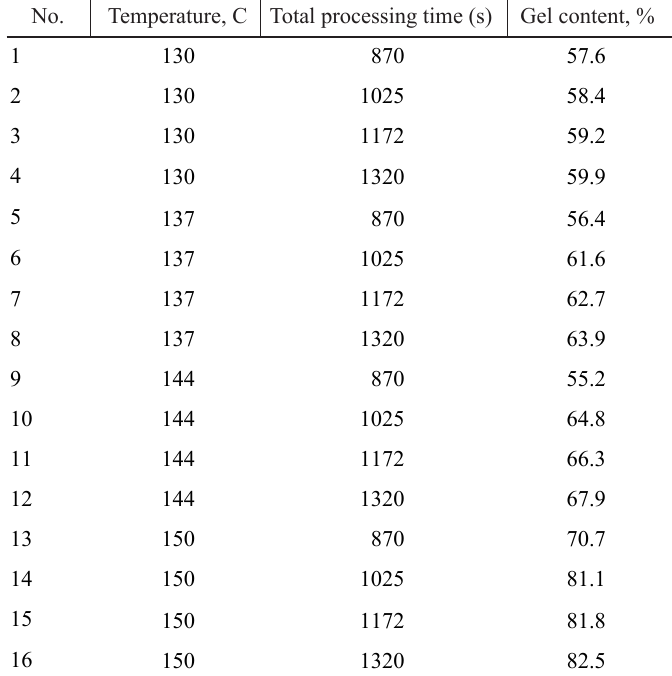
Only test data with the gel content value over 50% are